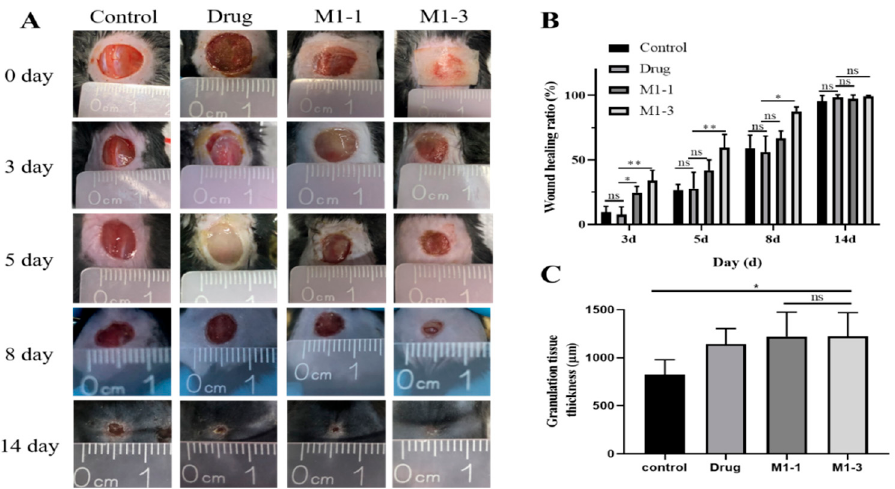
Figure 6. ( A ) the healing processes of wounds treated of diabetic mice, ( B ) wound healing ratios analysis, ( C ) granulation tissue thickness of the wounds at 14 day ( ns: p > 0.05; *: p < 0.05; **: p < 0.01 ) .